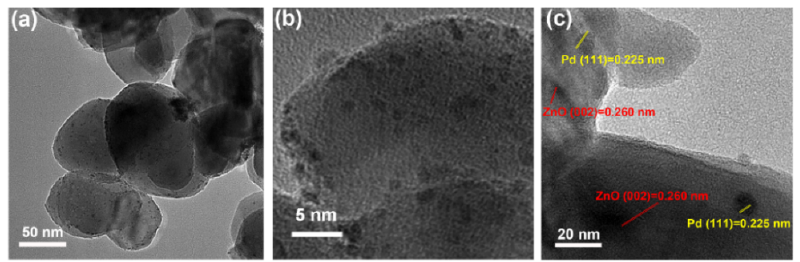
Figure 4. ( a ) TEM, ( b , c ) HRTEM images of Pd Cs-2/ZnO 1−x .